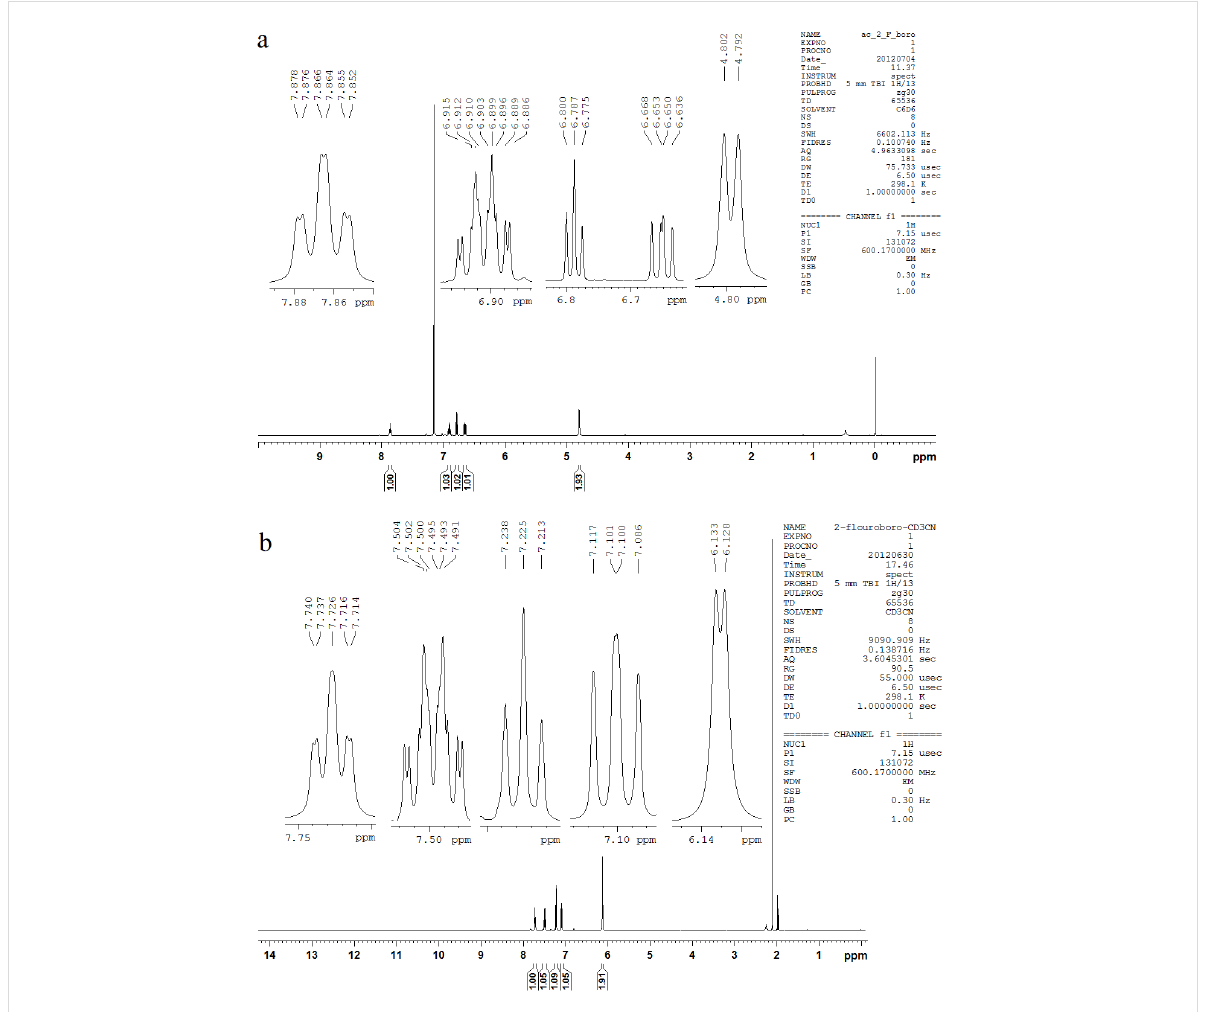
Figure 5: 1 H NMR spectrum for 1 in (a) C 6 D 6 solution (2 mg mL − 1 ) and (b) CD 3 CN solution (20 mg mL − 1 ).